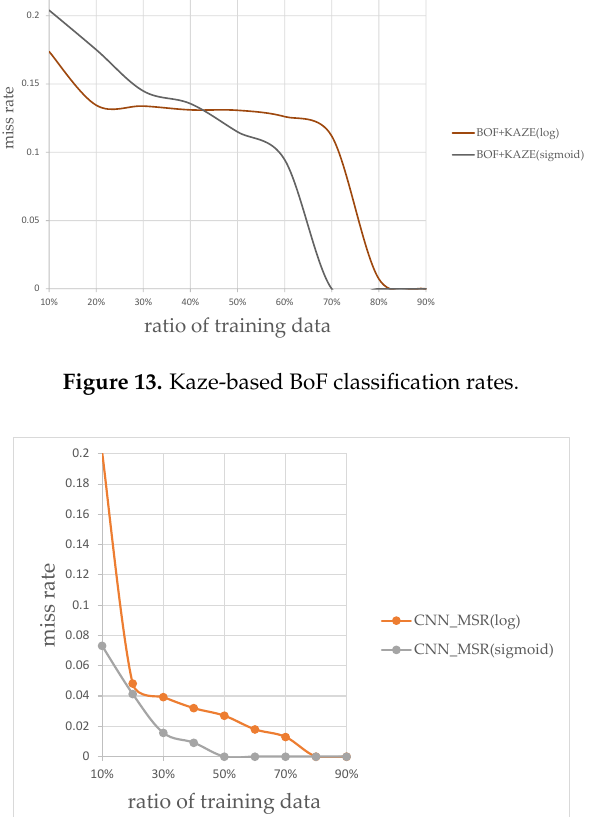
Table 2. BoF classifiers classification accuracy results. Classifier